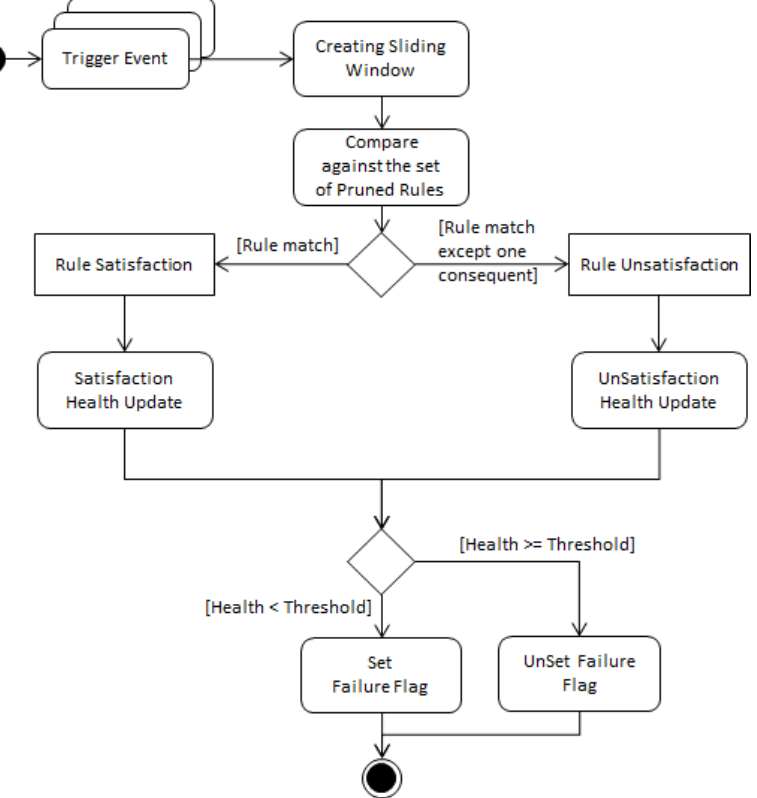
Figure 3. UML activity diagram of the health status